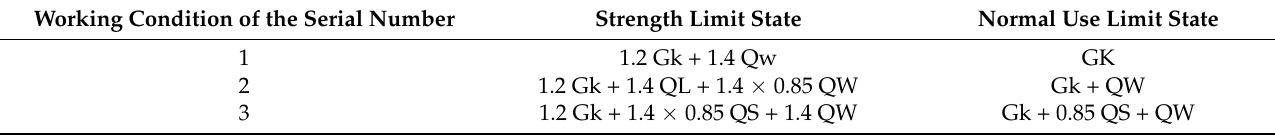
Table 4. Combination of working conditions of new energy vehicle charging post carport. G K is the constant load; Q L is the live load; Q W is the wind load; Q S is the snow